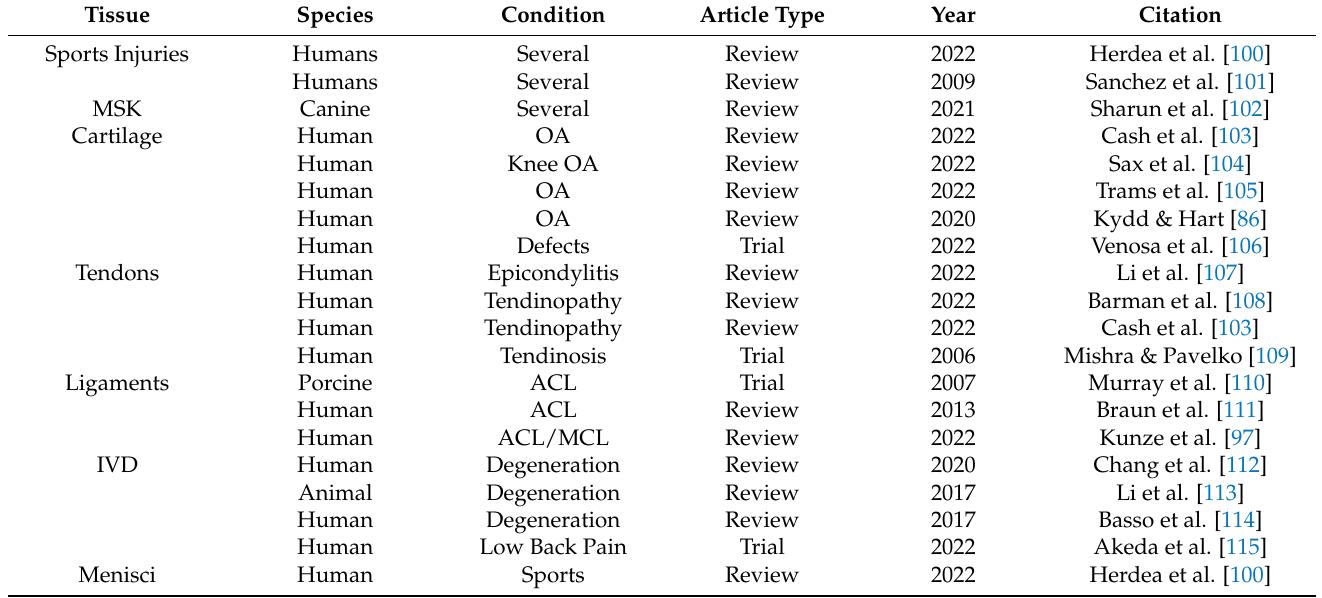
Table 1. Applications of Platelet-Rich Plasma in Cell Therapy for Connective Tissue Repair and